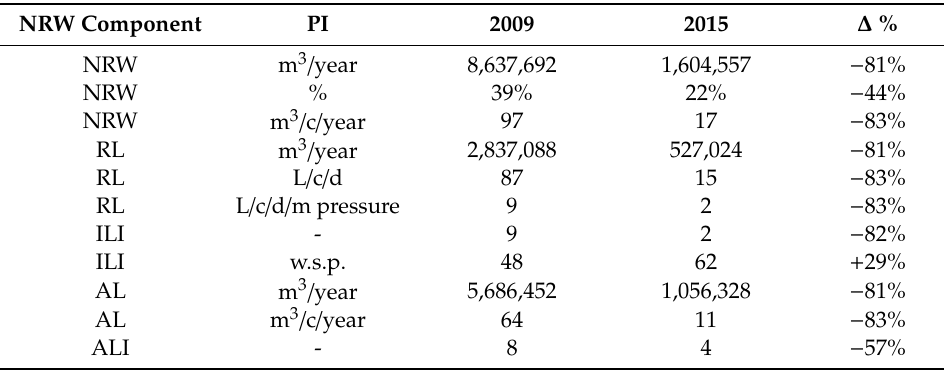
Table 2. NRW PIs of Sana’a for 2009 and